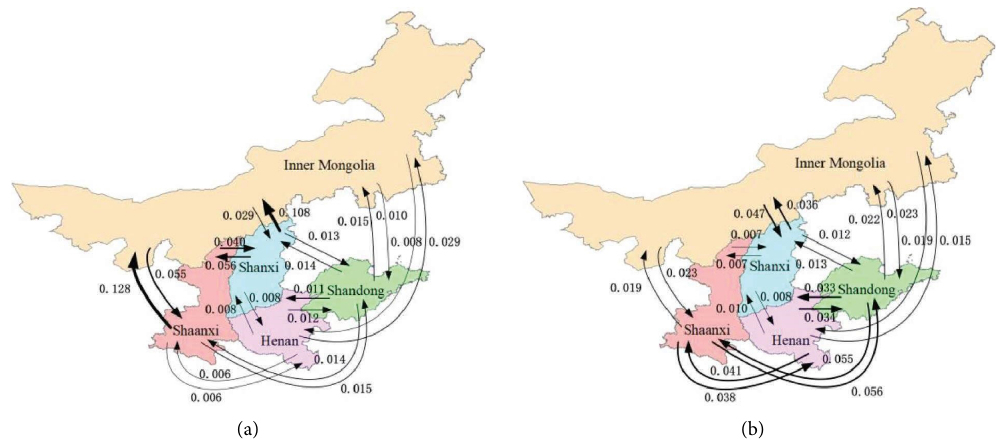
Figure 4: Te inter-regional circulation efect of 2012 and 2017. (a) 2012. (b)